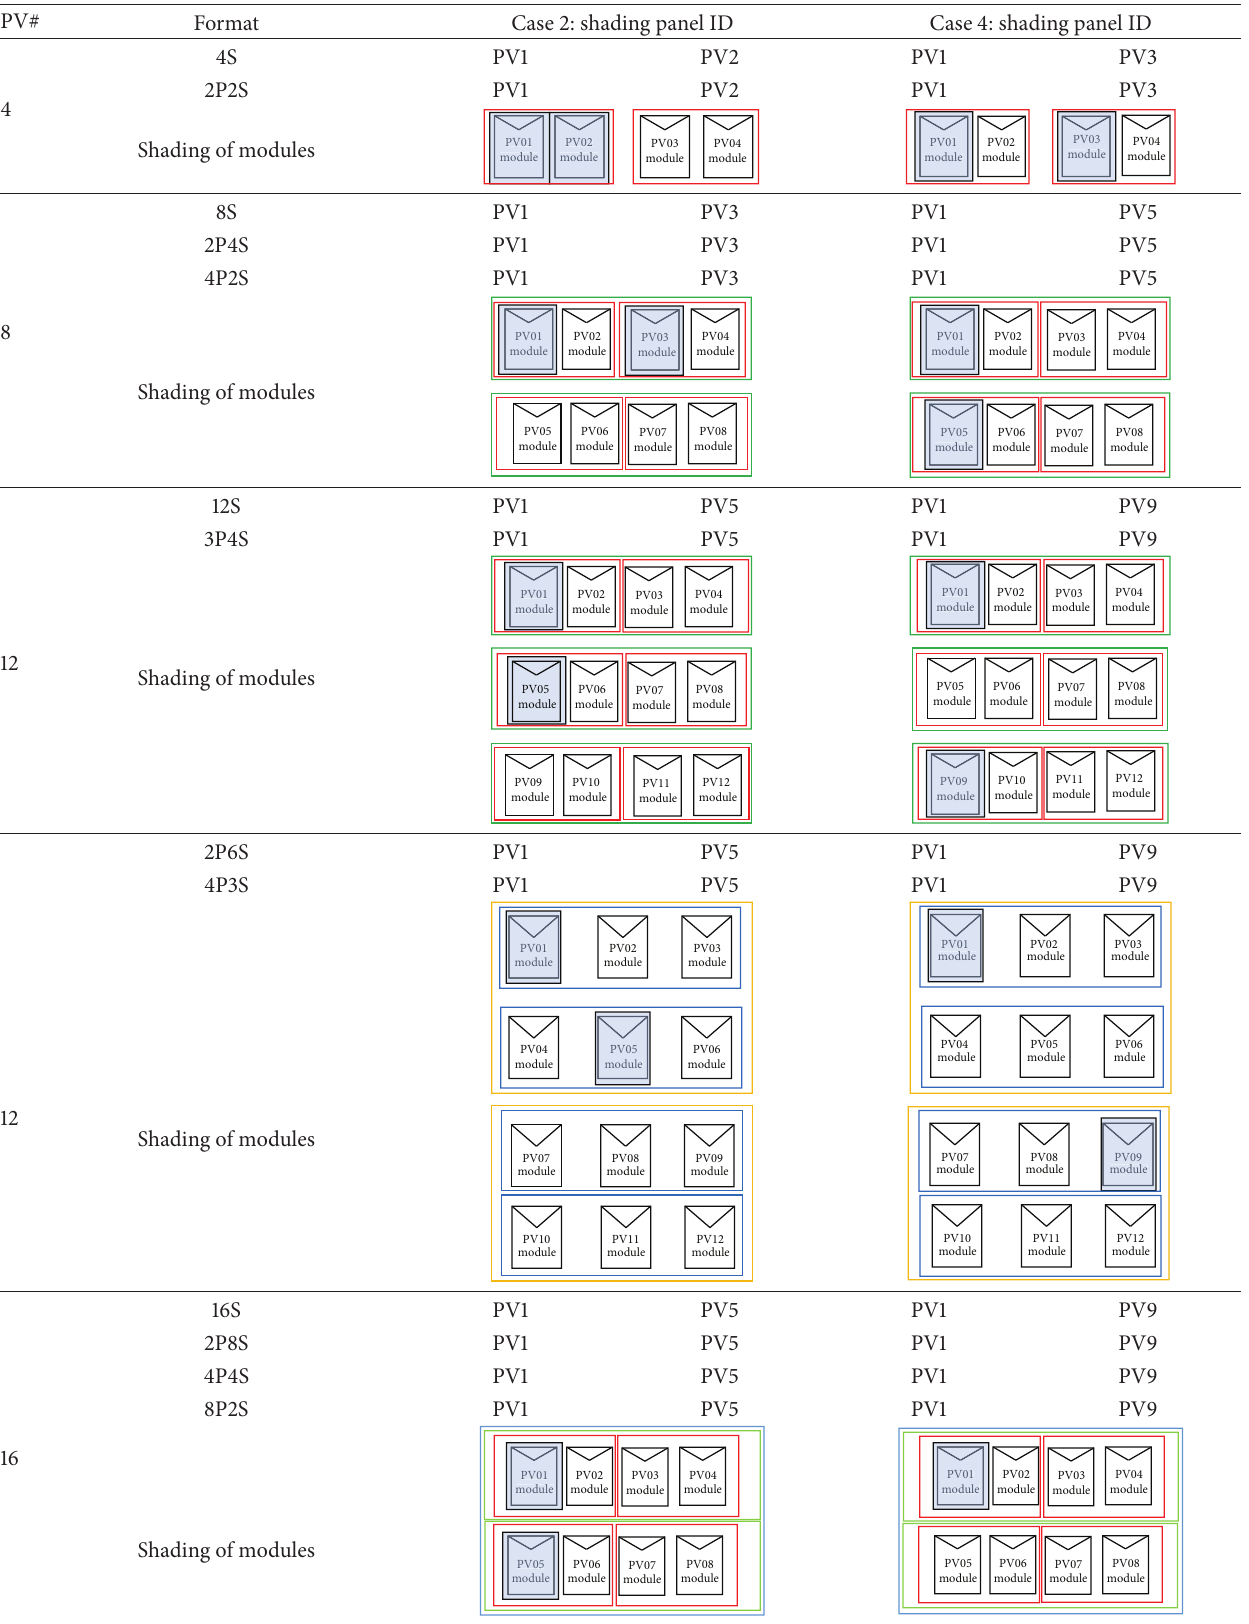
Table 6: PV string information and shading arrangement for MPPT